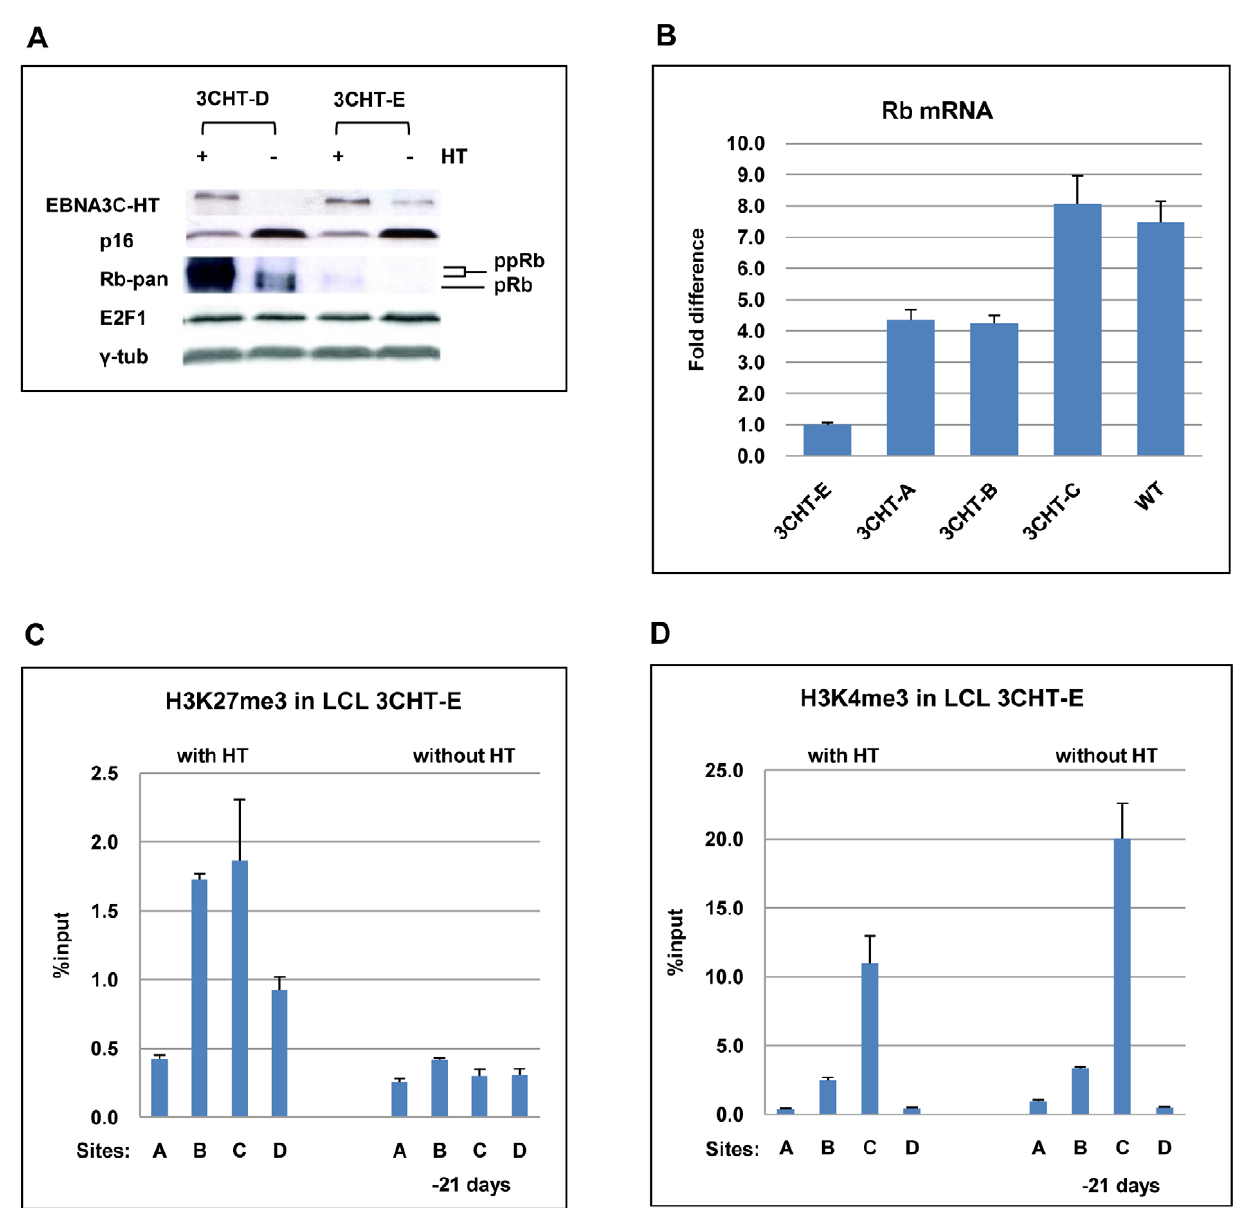
Figure 6. EBNA3C-mediated regulation of p16 INK4A does not require Rb. ( A ) Western blot analysis of whole cell lysates from two LCL 3CHT (- D and -E) cultured with ( + ) or without (-) HT for 26 days. Although Rb is undetectable in LCL 3CHT-E, when HT is removed from the growth medium, EBNA3C decreases and p16 INK4A (p16) increases. E2F1 and c -tubulin ( c -tub) levels do not alter. ( B ) Steady-state levels of Rb mRNA in LCL 3CHT-E relative to 3 other LCL 3CHT and a WT-BAC LCL all cultured with HT, quantified by qRT-PCR. ( C ) ChIP analysis of H3K27Me3 distribution across the p16 INK4A -ARF locus in LCL 3CHT-E cells (expressing little or no Rb) with HT or without HT in the growth medium. ( D ) ChIP analysis of H3K4me3 distribution across the p16 INK4 -ARF locus essentially as described in